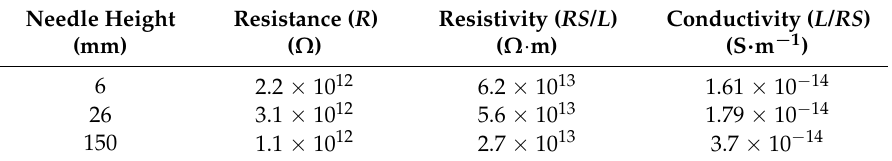
Table 5. The relationship between needle length and the resistivity of